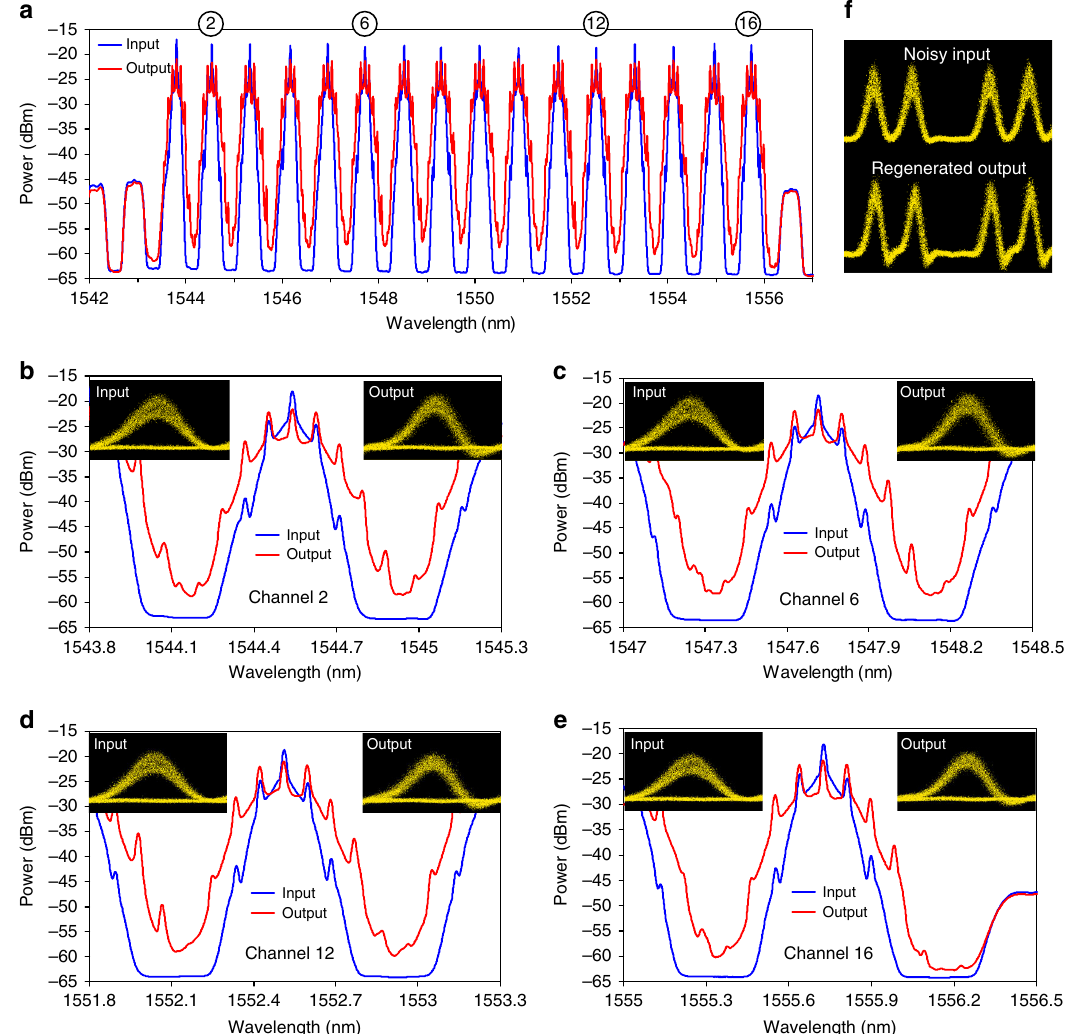
Fig. 6 Spectra and eye-diagrams before and after the stand-alone 2R regenerator. a – e Optical spectra of the noise-degraded signals at the regenerator input ( blue) and output ( red ) for all 16 channels ( a ) and four representative channels (detail view, b – e ), obtained with the resolution bandwidth of 0.016 nm. Corresponding eye diagrams are shown as insets. Encircled numbers at the top of a show positions of the four channels. f 5-bit pattern before and after regeneration (1555.75-nm